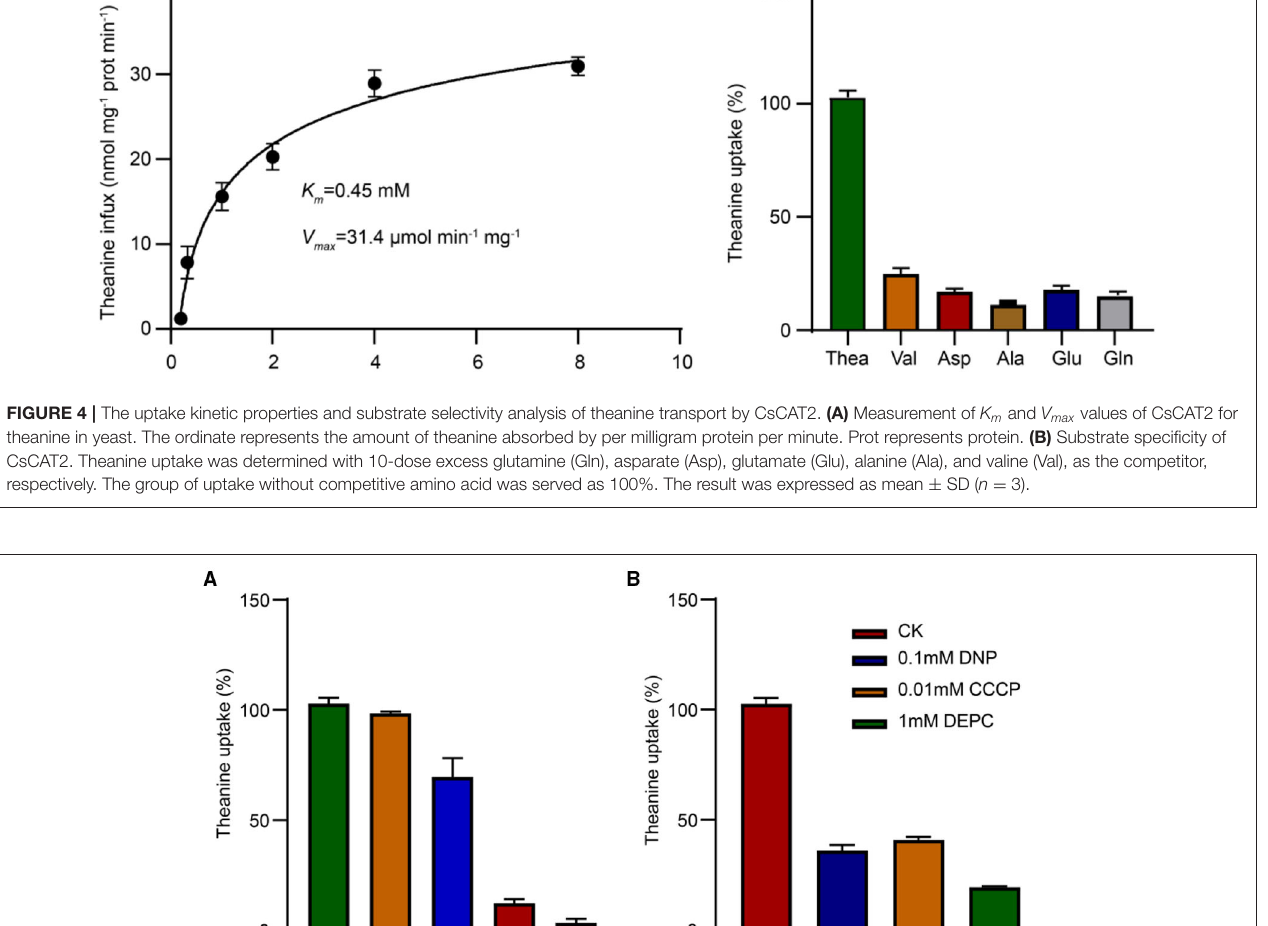
Frontiers in Plant Science |